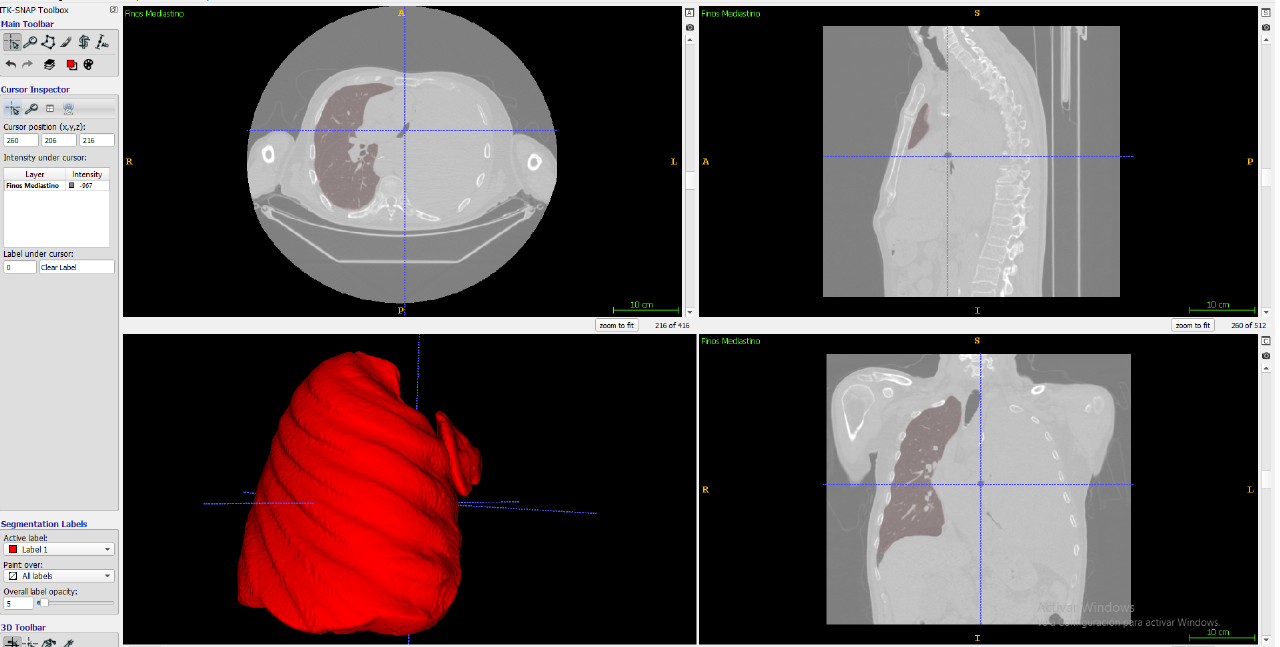
Figure 5. Lung segmentation in ITK-Snap.